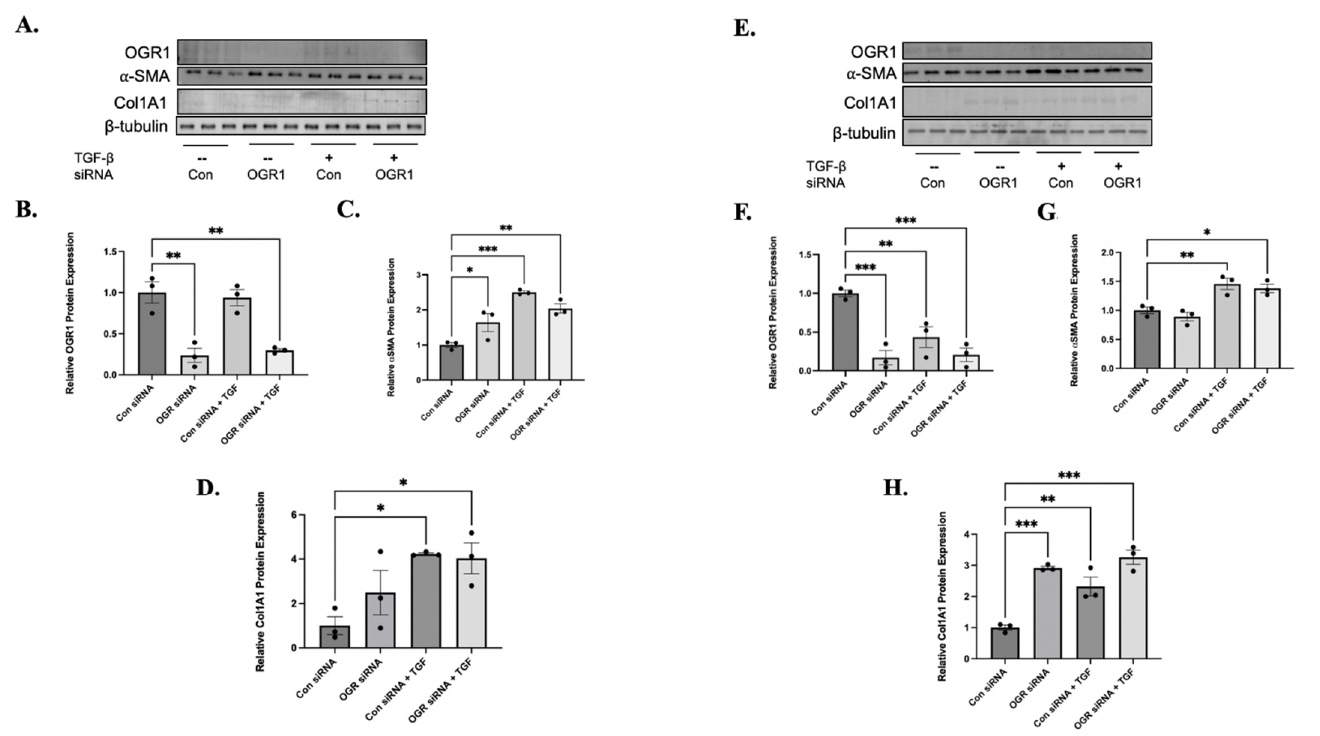
Figure 5. Knock-down of OGR1 expression does not have additive or synergistic effects on TGF- β induced myofibroblast differentiation. Human fibroblasts (healthy: A – D , IPF: E – H ) were transfected with either non-targeting (con) or OGR1 siRNA and were subsequently treated with either TGF- β 1 or DMSO as a control. Protein lysates were then harvested and western blotting was performed with antibodies against OGR1, α -SMA, collagen 1A1, and beta-tubulin (as a loading control). Representative western blots are presented ( A and E , respectively), and densitometry analysis is graphed below. OGR1 was successfully knocked down in both healthy ( B , ** p = 0.0010 and 0.0017) and IPF-derived fibroblasts ( F , *** p = 0.0007 and 0.0009). As previously demonstrated, treatment with TGF- β 1 decreased basal OGR1 expression in IPF-derived fibroblasts (** p = 0.0071). As expected, TGF- β 1 significantly increased expression of α -SMA in both healthy ( C , *** p = 0.0003 and ** p = 0.0028) and IPF-derived fibroblasts ( G , ** p = 0.0076 and * p = 0.02). Interestingly, in healthy fibroblasts, decreasing basal expression of OGR1 caused a significant increase in α -SMA expression ( C , * p = 0.0373). Again, as expected, treatment with TGF- β 1 caused increased collagen1A1 expression in healthy ( D , * p = 0.0364) and IPF fibroblasts ( H , *** p = 0.0037 and ** p = 0.0001, respectively). In IPF fibroblasts, decreasing basal expression of OGR1 caused increased collagen1A1 expression ( H , *** p = 0.0003). Suppressing OGR1 expression did not add to the ability of TGF- β to induced myofibroblast differentiation. Data represent mean expression ± SEM.